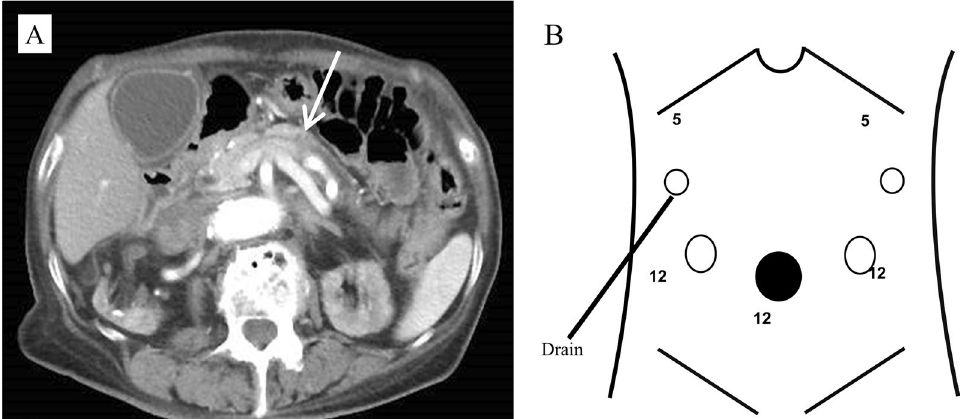
Fig. 1 Computed tomography findings and port placement. A Computed tomography showed a 12-mm-diameter mass lesion in the pancreatic body with dilatation of the main pancreatic duct (arrow). B Two 5-mm ports were placed in the left and right hypochondrium, two 12-mm ports were placed in the left and right lateral abdomen, and one 12-mm port was inserted in the umbilical region by the open